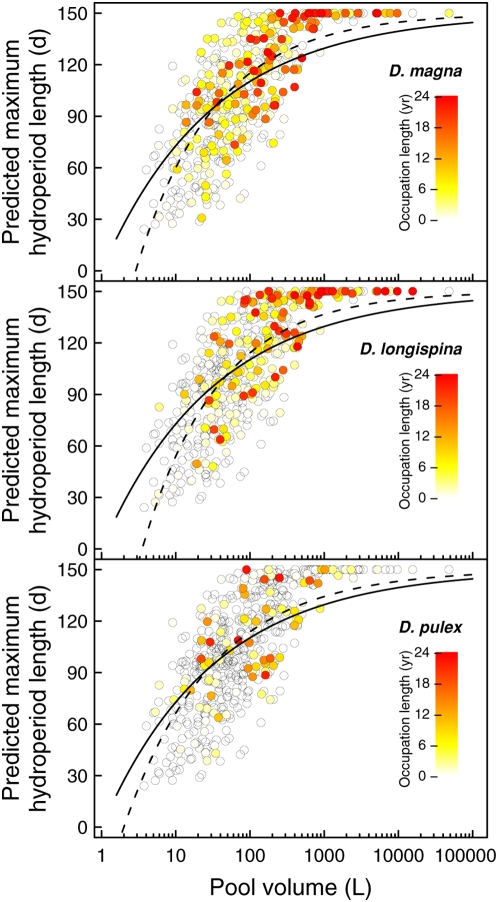
Occupation lengths of Daphnia versus hydroperiod lengths.Predicted average hydroperiod length (in days between 1 May and 30 September) per pool in relation to its maximal volume. Additionally, for each pool the occupation length for D. magna, D. longispina and D. pulex populations is given separately in a colour gradient. The predicted hydroperiod length was non-linearly correlated with pool volume. Nonlinear least square fits between pool volume and predicted hydroperiod length are given for all pools (straight line) and separately for the subset of pools that was at least once inhabited by the specific species (dashed line).